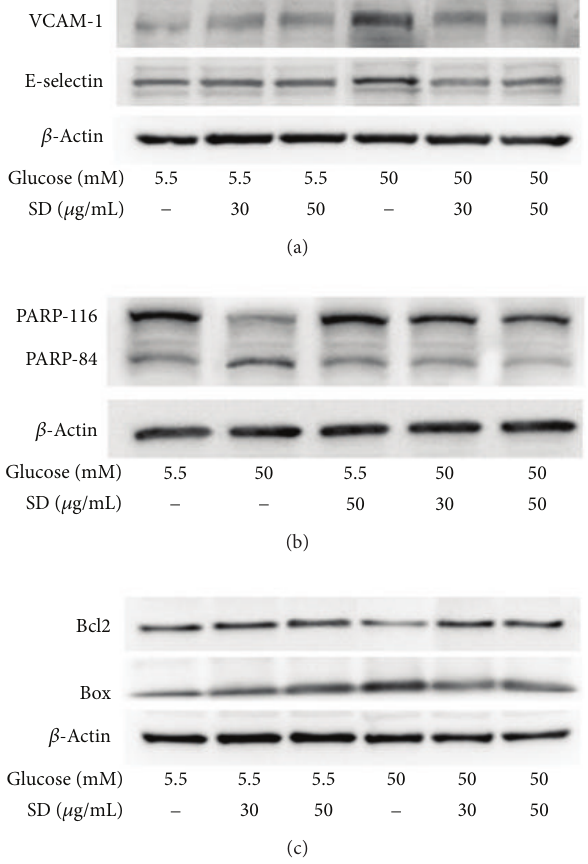
Figure 4: Effects of SD on HG-induced expression of VCAM- 1, E-selectin, PARP-1, and Bax/Bcl2 in HUVEC: HUVECs (2 × 10 5 cells/well) were pretreated with SD (30 and 50 𝜇 g/mL) for 2 h and then treated with glucose (50mM) for 30 min to detect the expression of (a) VCAM-1 and E-selectin, (b) PARP-1, and (c) Bax/Bcl2. The 𝛽 -actin was used as an internal